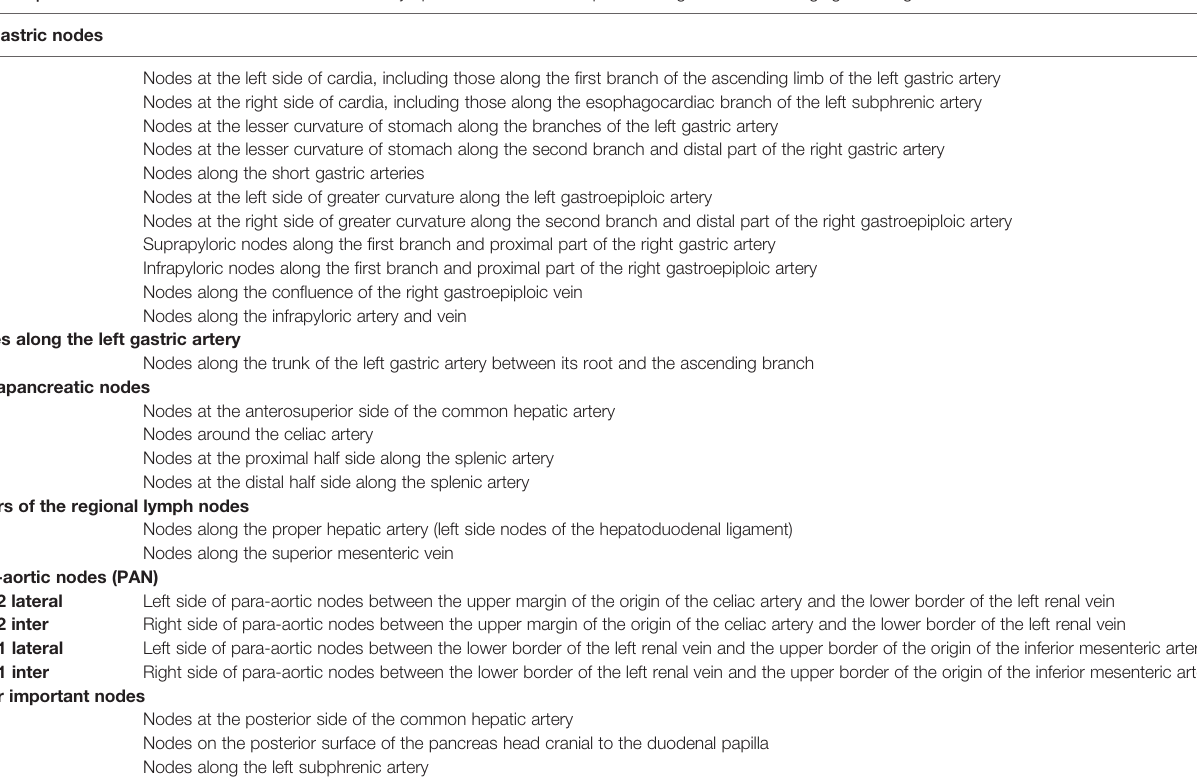
TABLE 2 | The station numbers and the de fi nitions of the lymph nodes which are important for gastric cancer staging and surgical treatment. Perigastric